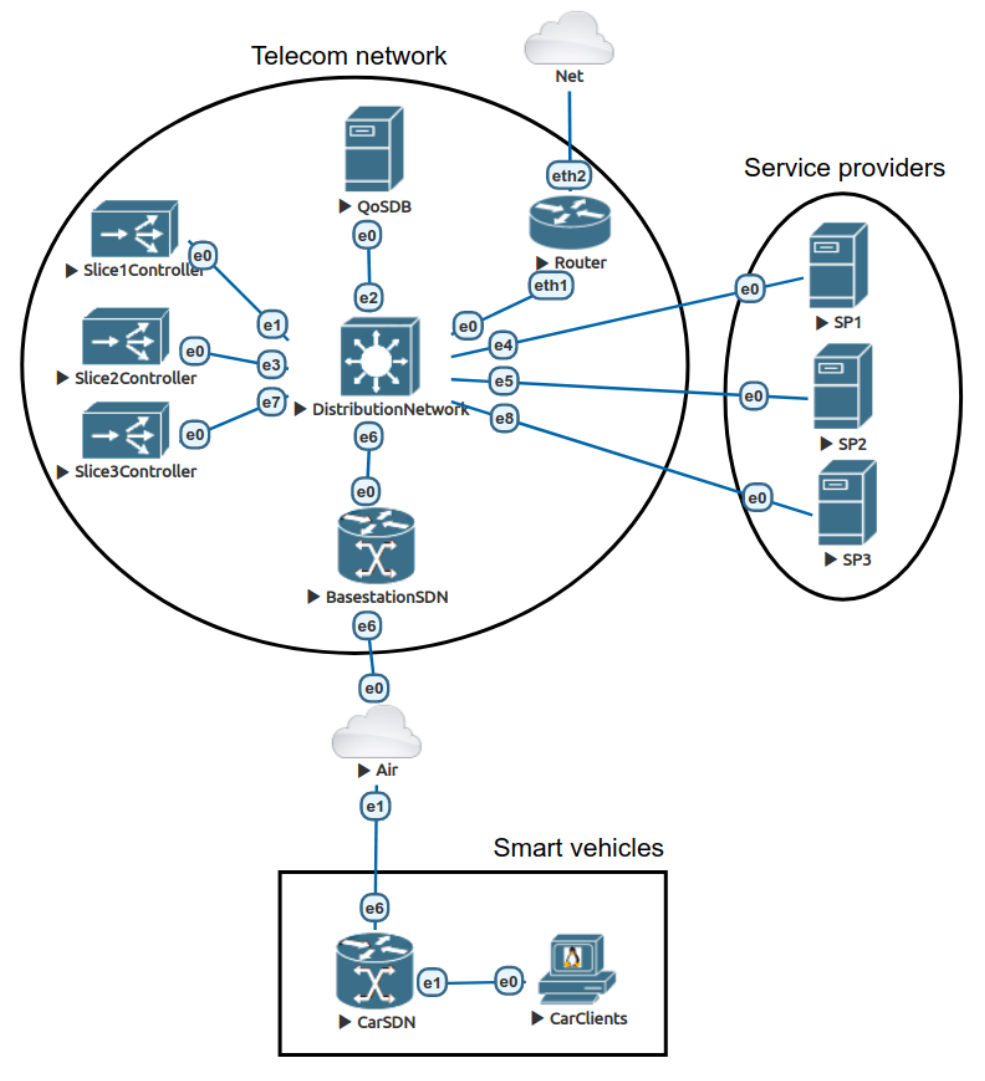
Figure 4. The design of the testbed